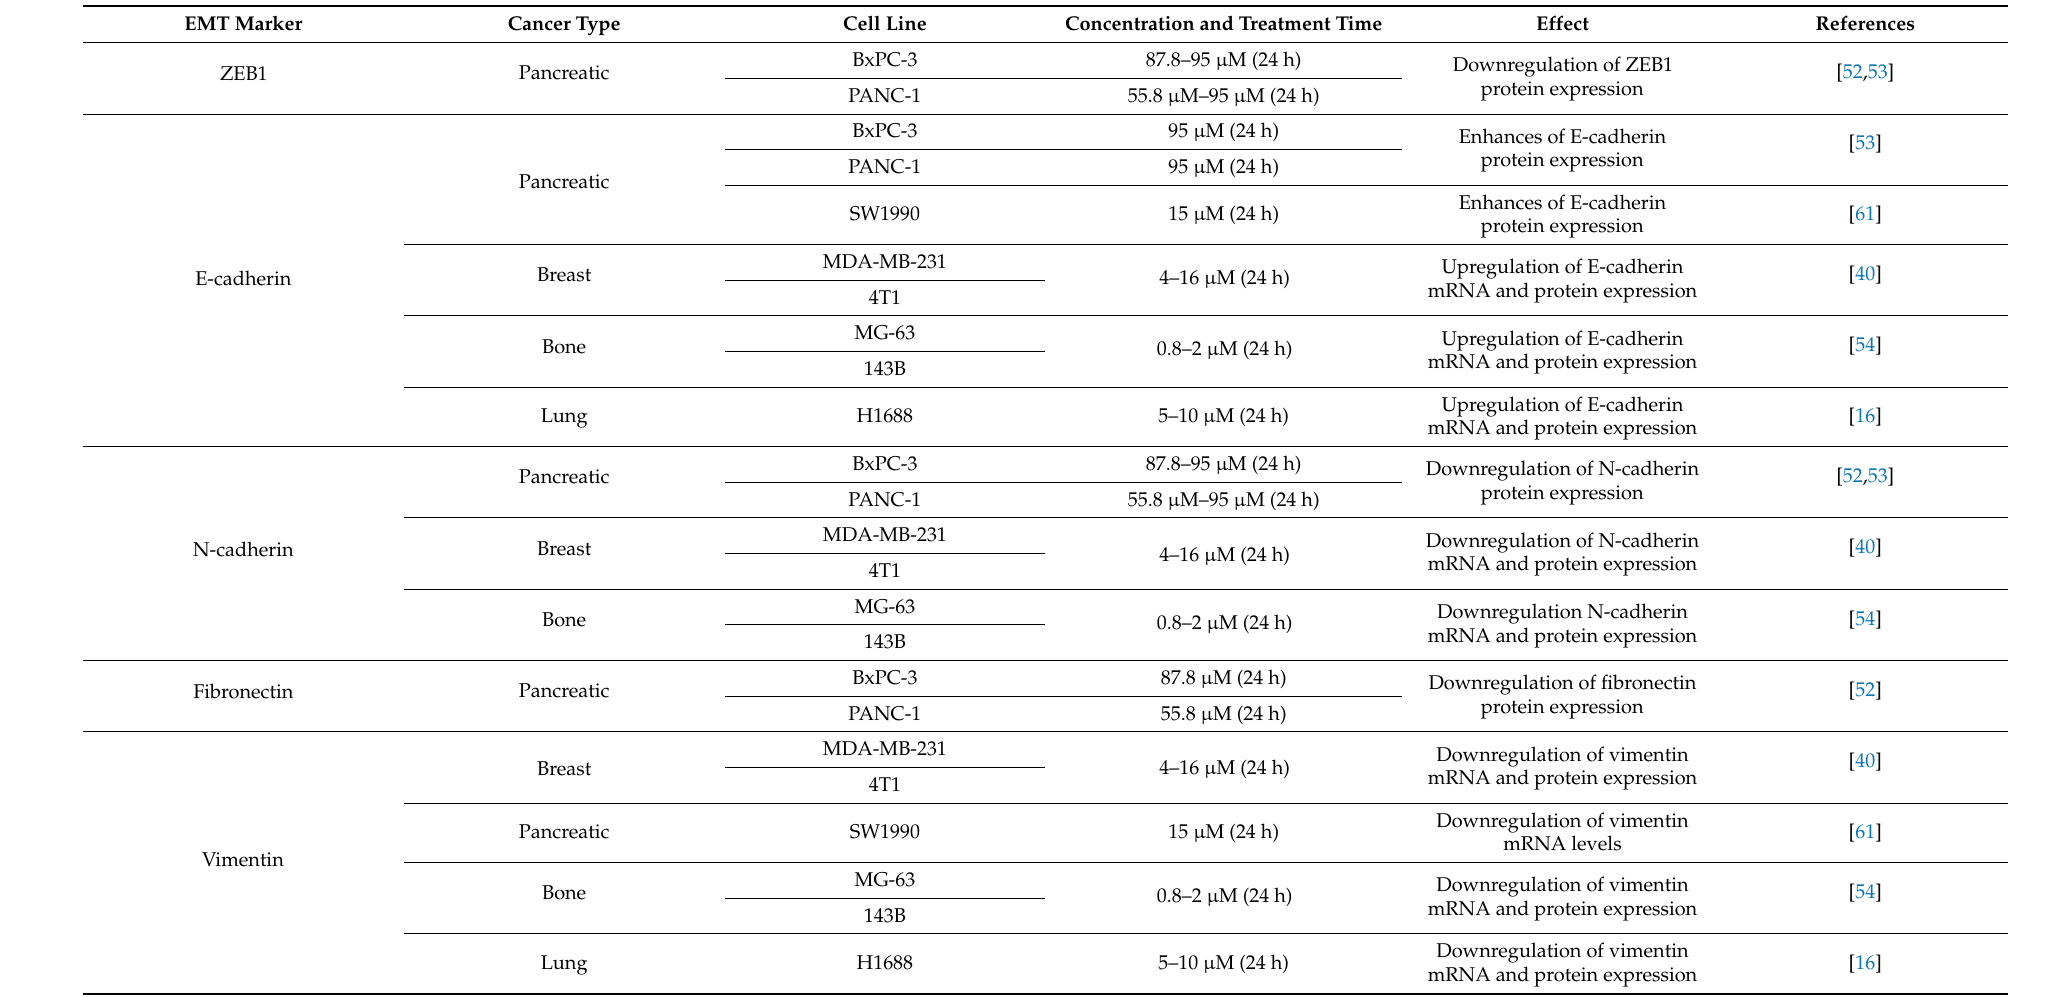
Table 1. Effects of EMT markers modulated by